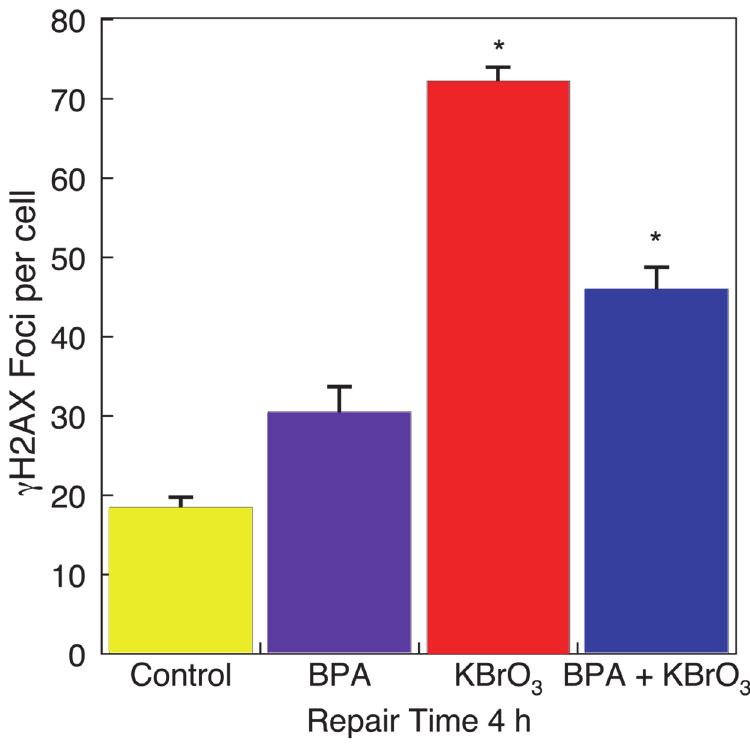
Fig 4. Strand break signaling by γ H2AX in Ku70-deficient cells. γ H2AX foci were measured at 4 h after exposure to BPA alone, KBrO 3 alone, and after co-exposure (see Material and Methods). Each bar represents mean ± SEM of three independent experiments ( * p < 0.05 vs.